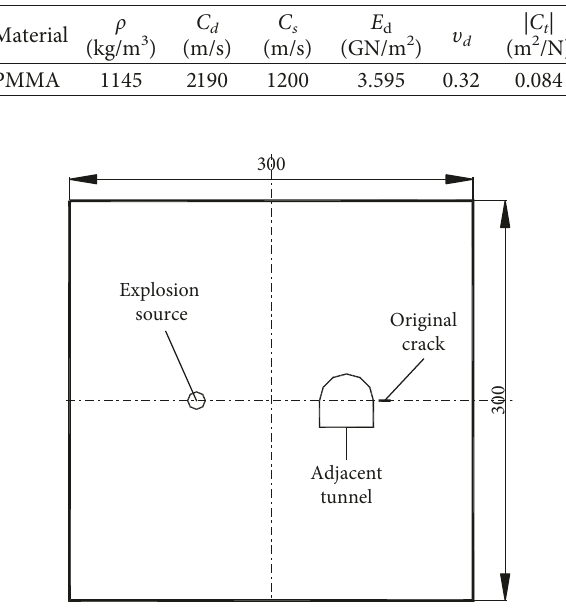
Figure 3: Schematic diagram of the experimental